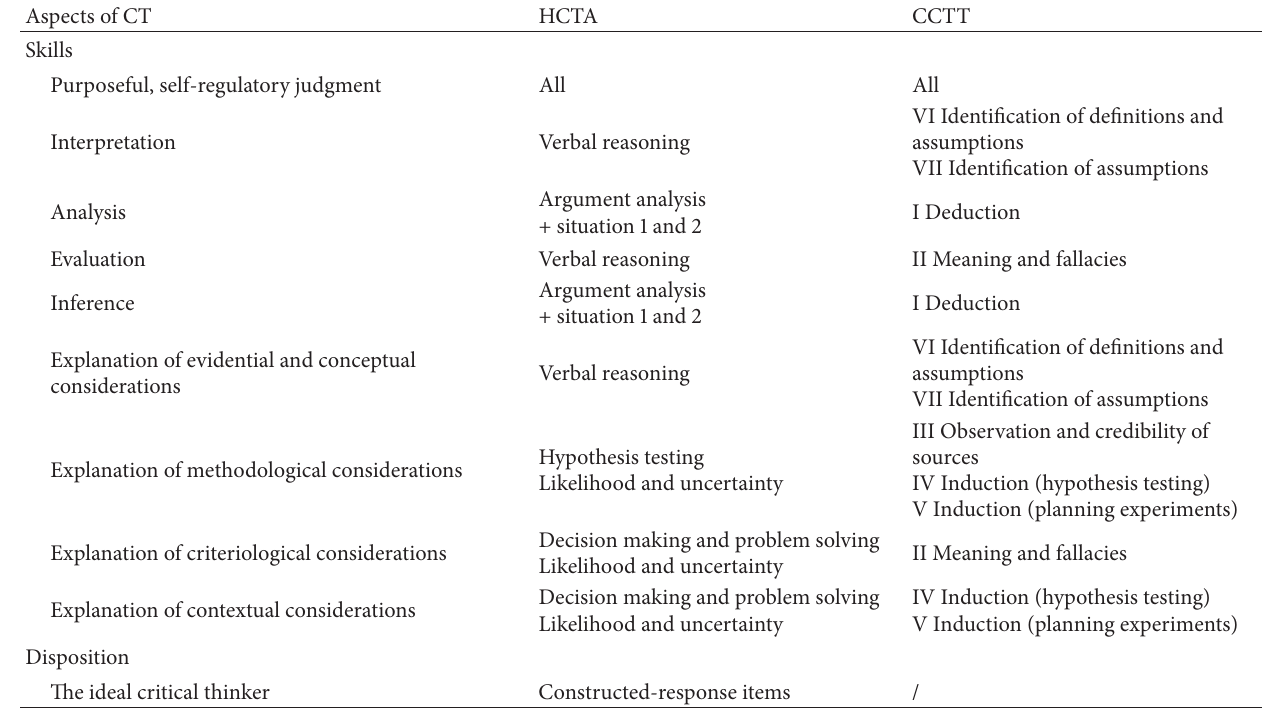
Table 8: Content validity: match between the used definition of CT and the elements measured in the two tests. Aspects of CT